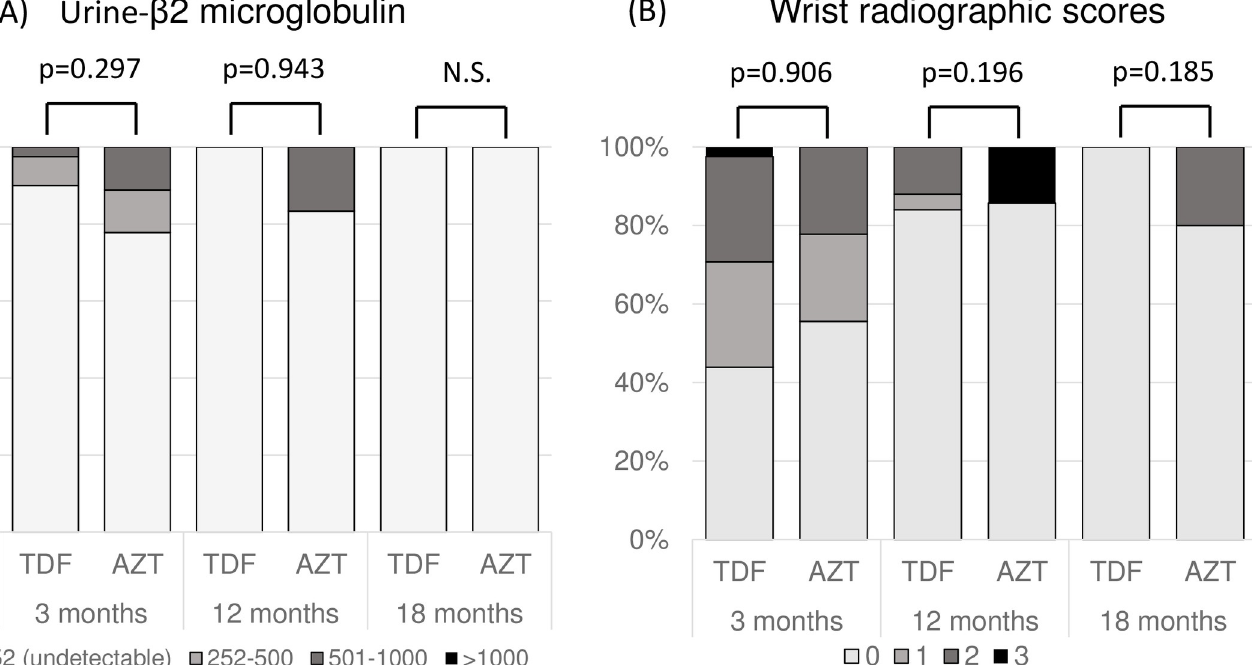
PLOS ONE | https://doi.org/10.1371/journal.pone.0250828 April 29,